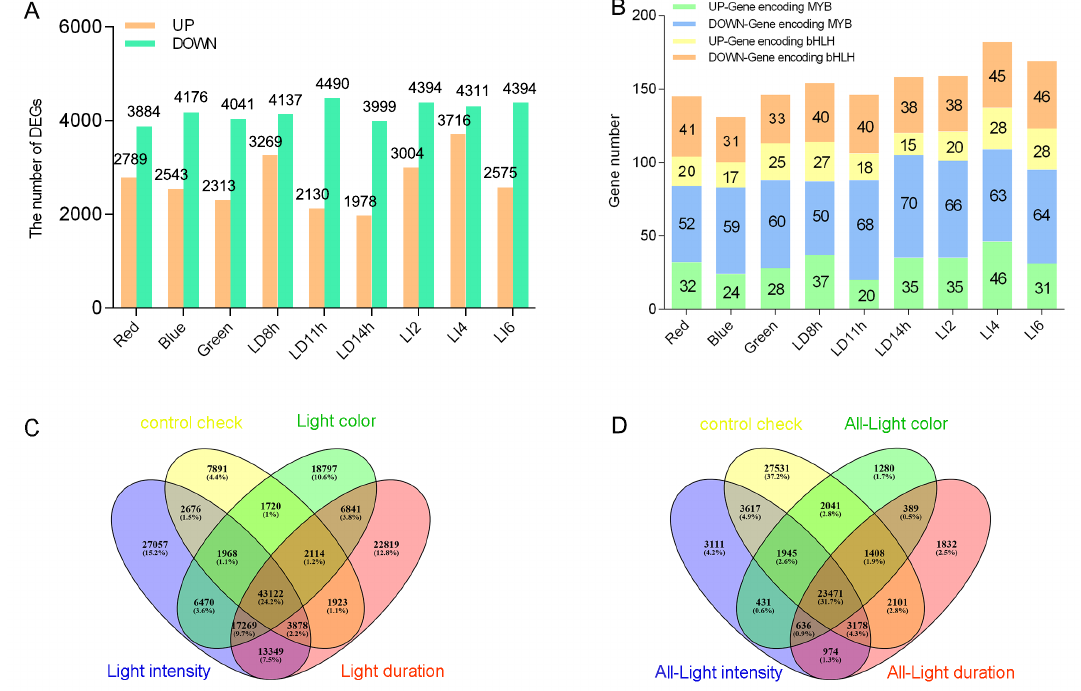
Figure 2. Di ff erentially expressed genes in response to various light conditions. ( a ) Up-regulated and down-regulated genes in each treatment group. ( b ) Di ff erentially expressed genes encoding MYB and bHLH transcription factors. ( c ) Venn diagram presenting the genes expressed in the control group and the genes expressed in response to at least one treatment for each light condition. ( d ) Venn diagram presenting the genes expressed in the control group and the genes expressed in response to all of the light